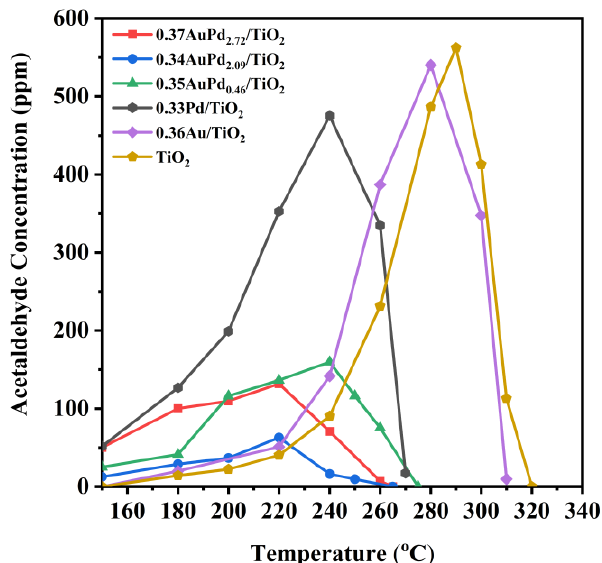
Figure 6. Acetaldehyde concentration as a function of temperature over the samples at SV = 40,000 mL/(g h).